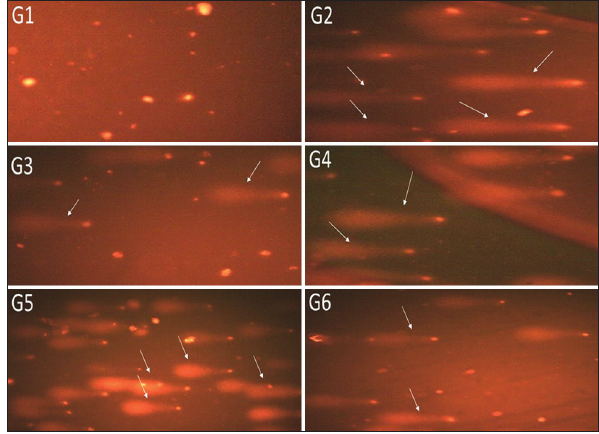
Figure-5: Effect of single and repeated intravenous injection of 300 μ g/kg body weight 50 nm either gold nanospheres (AuNSs) or gold nanorods (AuNRs) in male rabbits on comet test parameters on day 8 post-treatment. It shows white blood cells with fluorescent DNA comets 8 days post-treatment. G1 represents the control negative (non-treated non-vaccinated) group with intact cells. G2 represents control positive (vaccinated only), which shows the highest degree of DNA damage with the longest tail. The same high degree DNA damage was in G5. On the contrary, G3 (AuNSs single IV dose) shows the lowest degree of DNA damage. On the other hand, in G4 and G6 (AuNRs single and repeated IV dose), little degree of DNA damage was seen. Some cells showing comets were marked with white